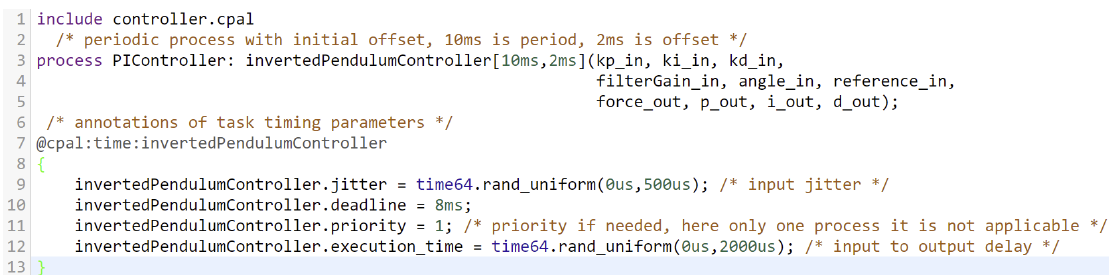
Figure 5. Snippet of CPAL code instantiating a controller of period 10 ms and offset 2 ms and specifying the variation of the input jitter J h and the input-to-output delay τ during a simulation run. This is achieved through a timing annotation executed in simulation, but ignored once on